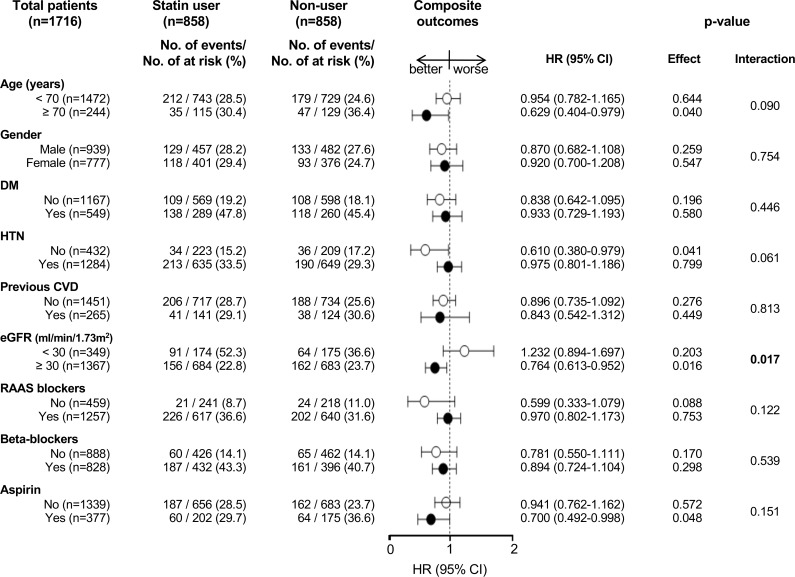
Association of statin treatment and composite outcomes in subgroups of matched cohort.